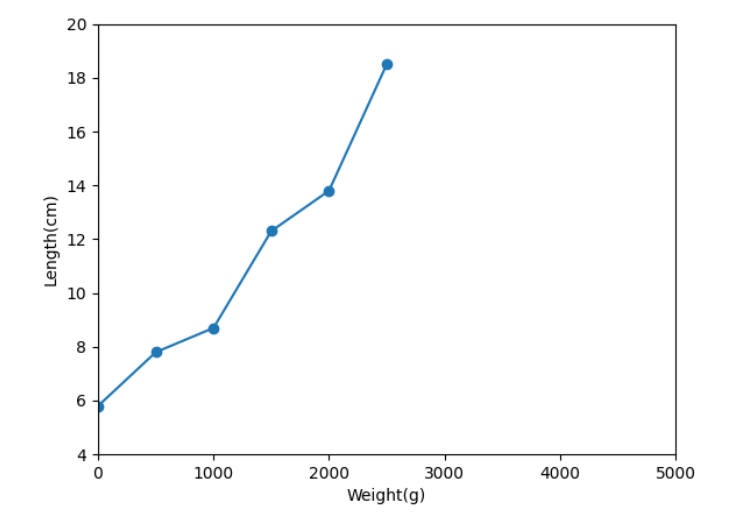
Figure 20. Graph of the height of the tip of the lower arm with a 500 g weight attached to the tip of the lower arm when it is pulled upward by the other weights. The height without the 500 g weight on the tip of the lower arm was 17.7 cm.